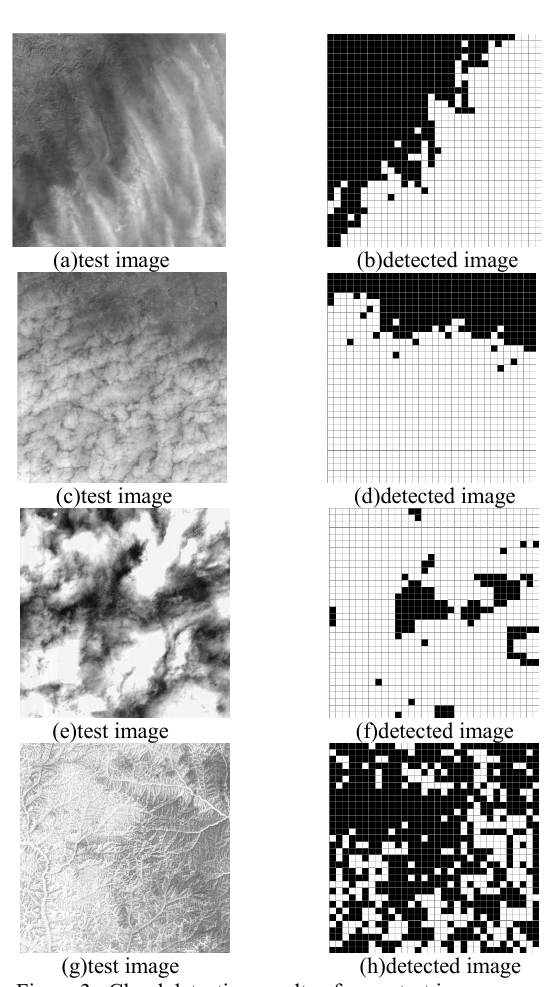
Figure 3. Cloud detection results of some test